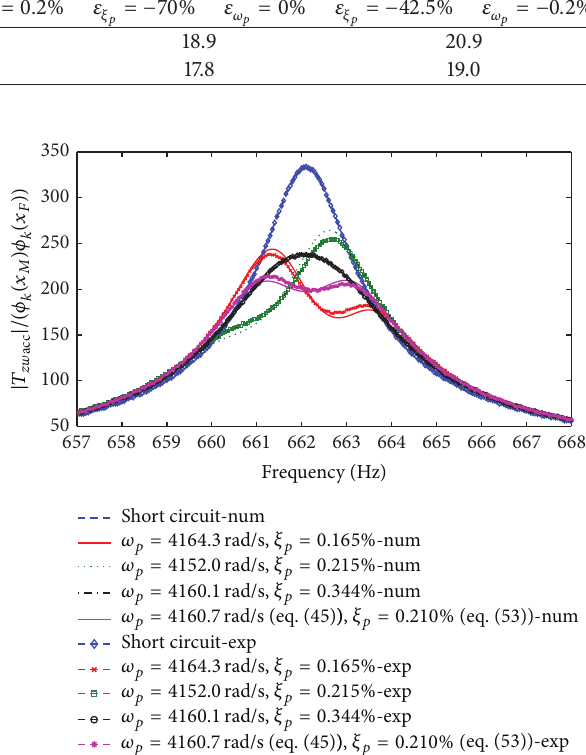
| (nor- Figure 28: Numerical and experimental trend of |𝑇 𝑧𝑤 acc malised over Φ 𝑘 (𝑥 𝑀 )Φ 𝑘 (𝑥 𝐹 ) ) for the mode at about 660 Hz (Table 7) and fixed values of 𝜔 𝑝 and 𝜉 𝑝